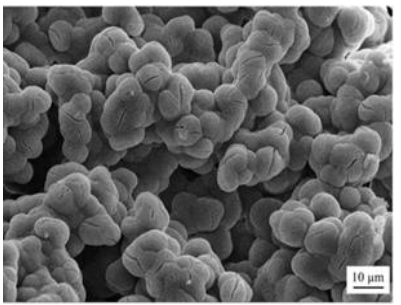
Figure 8. The SEM micrograph of the section of sc-PLAG-4%.